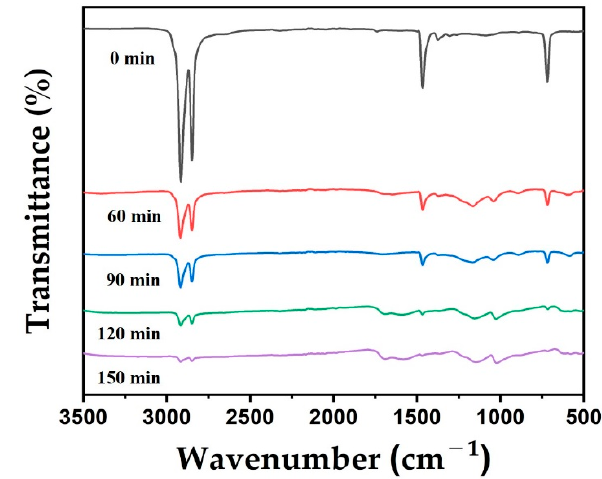
Figure 7. FTIR patterns of the sulfonated LDPE / HDPE sheath-core fibers for various crosslinking time at 130 °C.